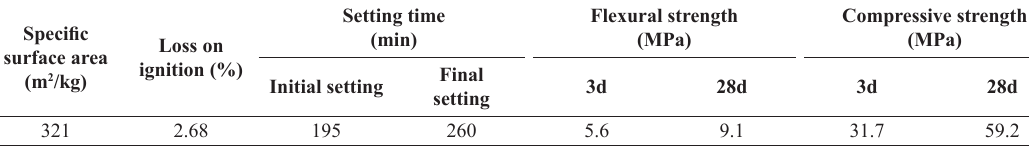
Table 2. The detailed physical parameters of PAN fiber. PAN fiber